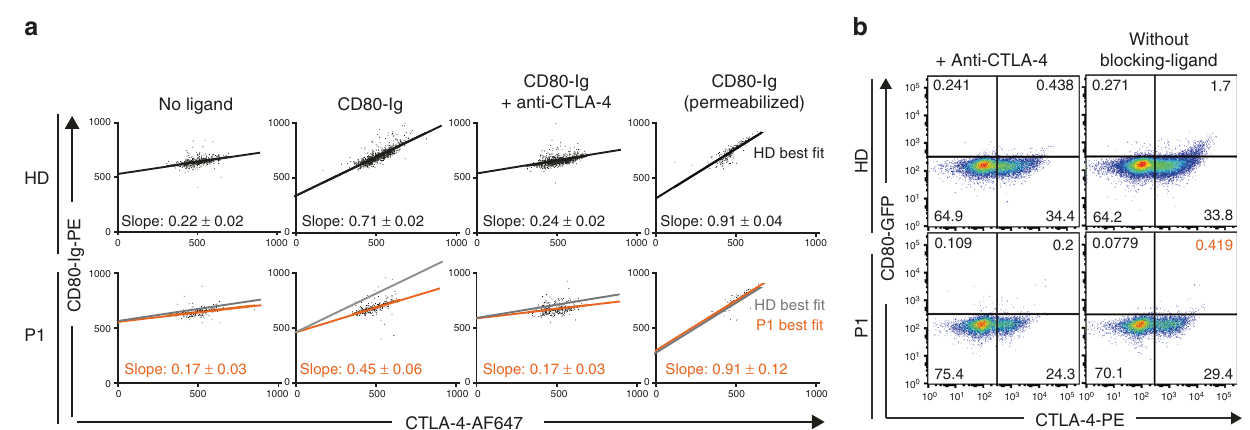
Fig. 4 DEF6 mutations affect CD80 ligand uptake by CTLA-4. a Ligand uptake assay of memory T regs reveals reduced uptake of CD80-Ig in P1 cells (bottom, orange lines) compared to HD control (top and bottom, black/gray lines), as depicted by the reduced slope of the best- fi t lines. Puri fi ed CD4 T cells were stimulated with anti-CD3/anti-CD28 antibody-coated beads (16 h). CD80-Ig and anti-CTLA-4 (where applicable) antibodies were present during stimulation. Anti-CTLA-4 blocked ligand uptake in both samples. For permeabilization control, CD80-Ig was added after fi xation/permeabilization, for binding all available CTLA-4. Data from fl ow cytometry were extracted, visualized and analyzed with Prism. Slopes were calculated with linear regression. Gating as in Fig. S3k. Representative of two independent experiments. b Transendocytosis assay of CD4 T cells shows reduced CD80-GFP capture by P1 cells from CHO cells, indicated by reduced CTLA-4 + CD80 + double-positive populations (orange numerical insert). Presence of anti-CTLA-4 blocked transendocytosis. Cells were stimulated for 16 h with anti-CD3 antibody. Co-stimulatory signal was provided by CD80-GFP expressing cells. Quanti fi cation as in Fig. S3j, gating as in Fig. S3l. Representative of two independent experiments. Source data of Fig. 4 are provided as a